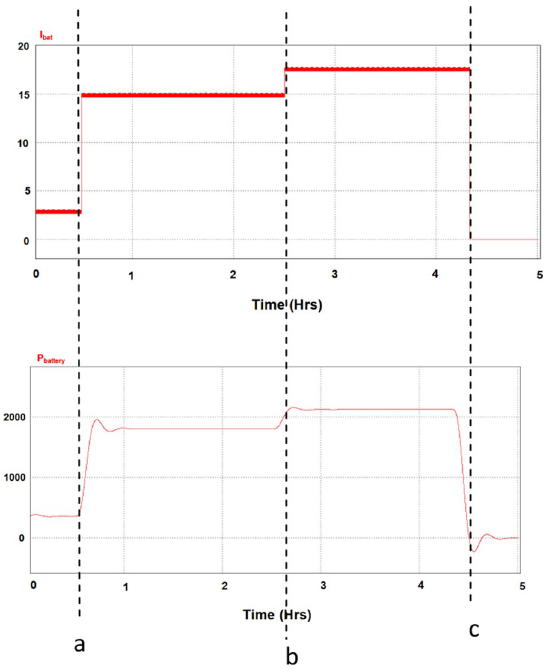
Fig. 12 Battery protection system—deep